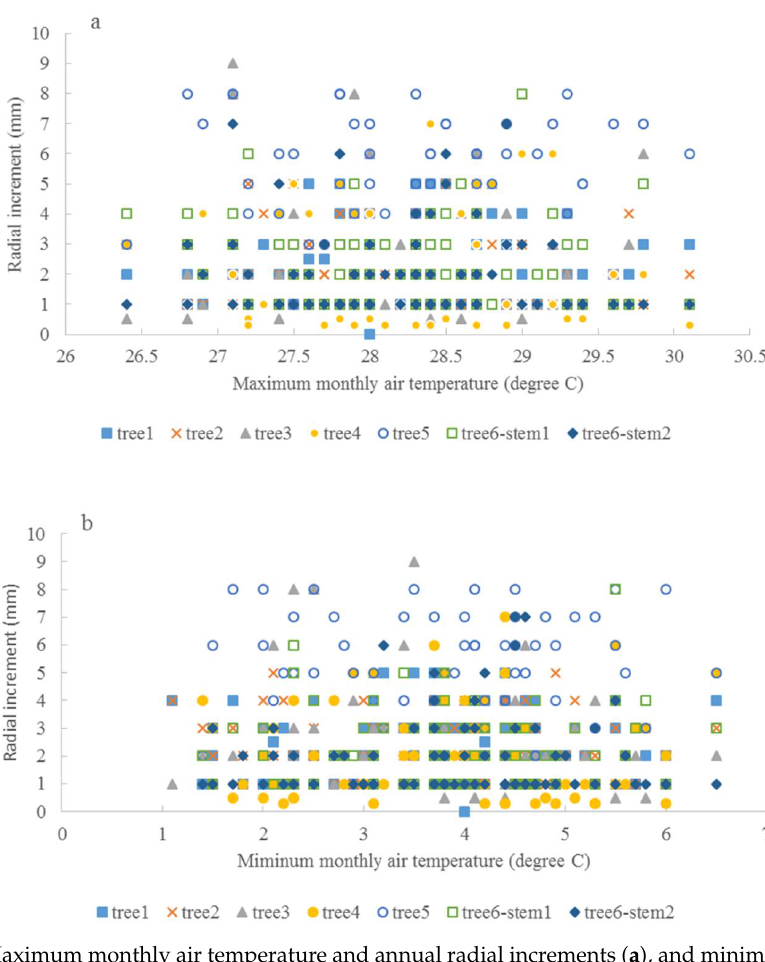
Figure 9. Maximum monthly air temperature and annual radial increments ( a ), and minimum monthly air temperature and annual radial increments ( b ).